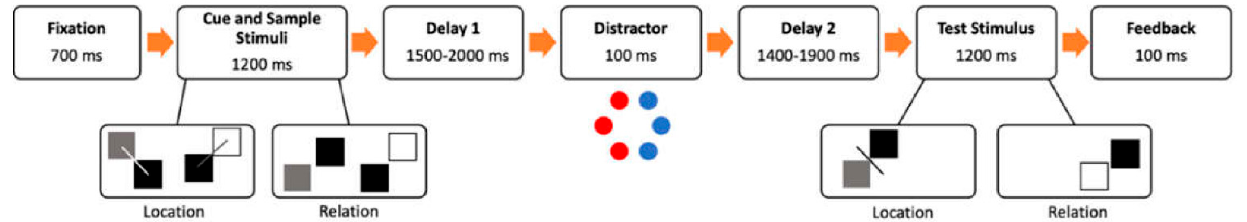
Figure 1. A schematic of the VDAC WM task for the location and relation trials. The red and blue dots represent an example of a presented distractor.